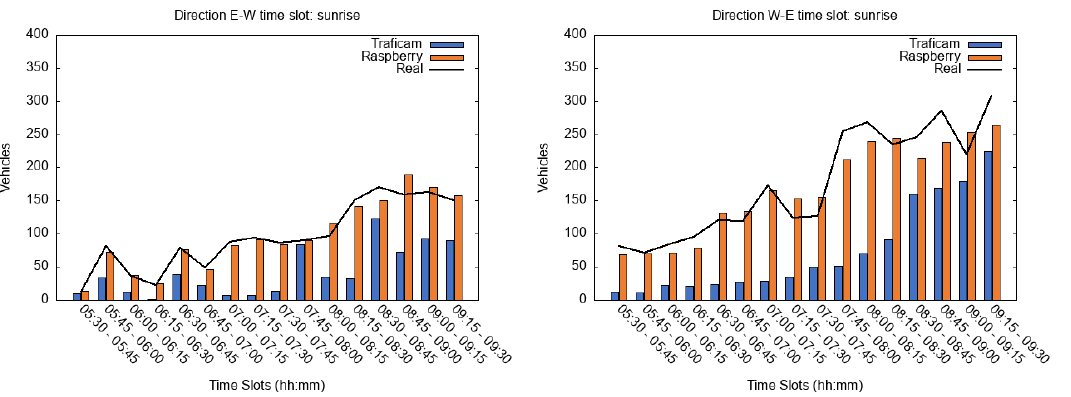
Figure 7. Comparison of Traficam (in blue) and Edge device (in orange) for vehicle counting during the sunrise time slot. On the left part of the figure, the direction E-W is shown, on the right part the direction is